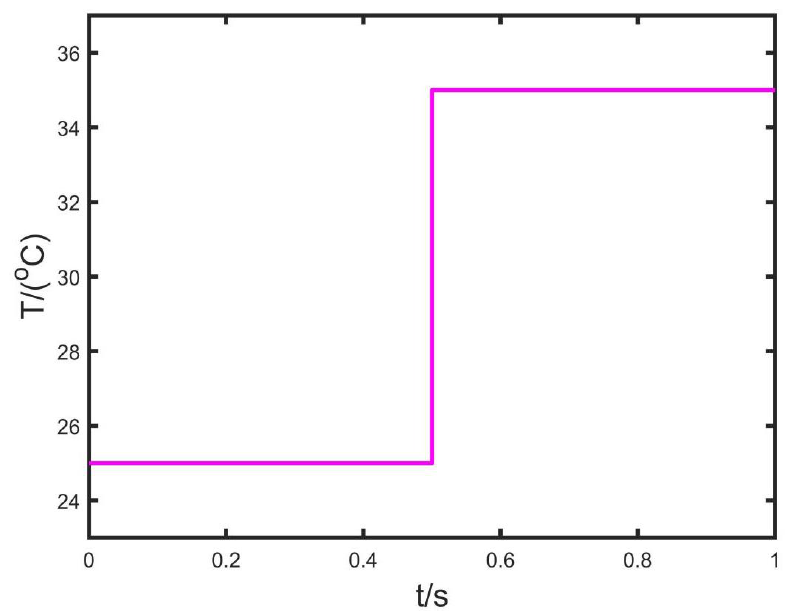
Figure 15. PV cell PV1 temperature change curve.